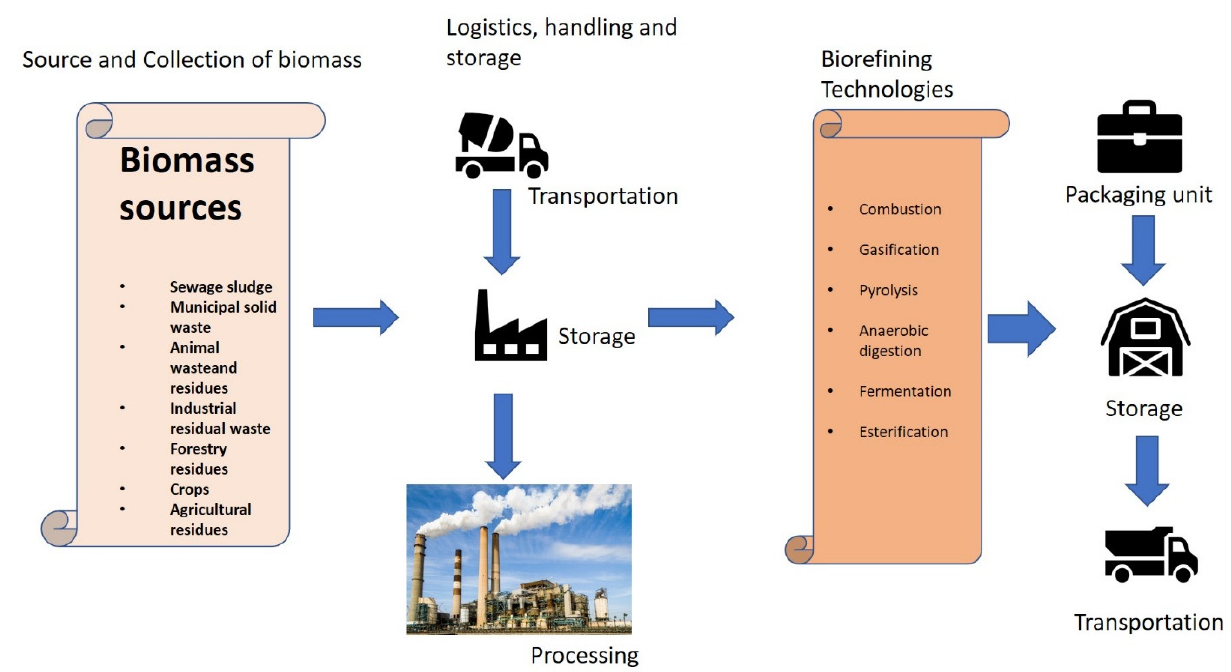
Figure 1. Technologies for refining biomass and logistics for handling, transport, and distribution.